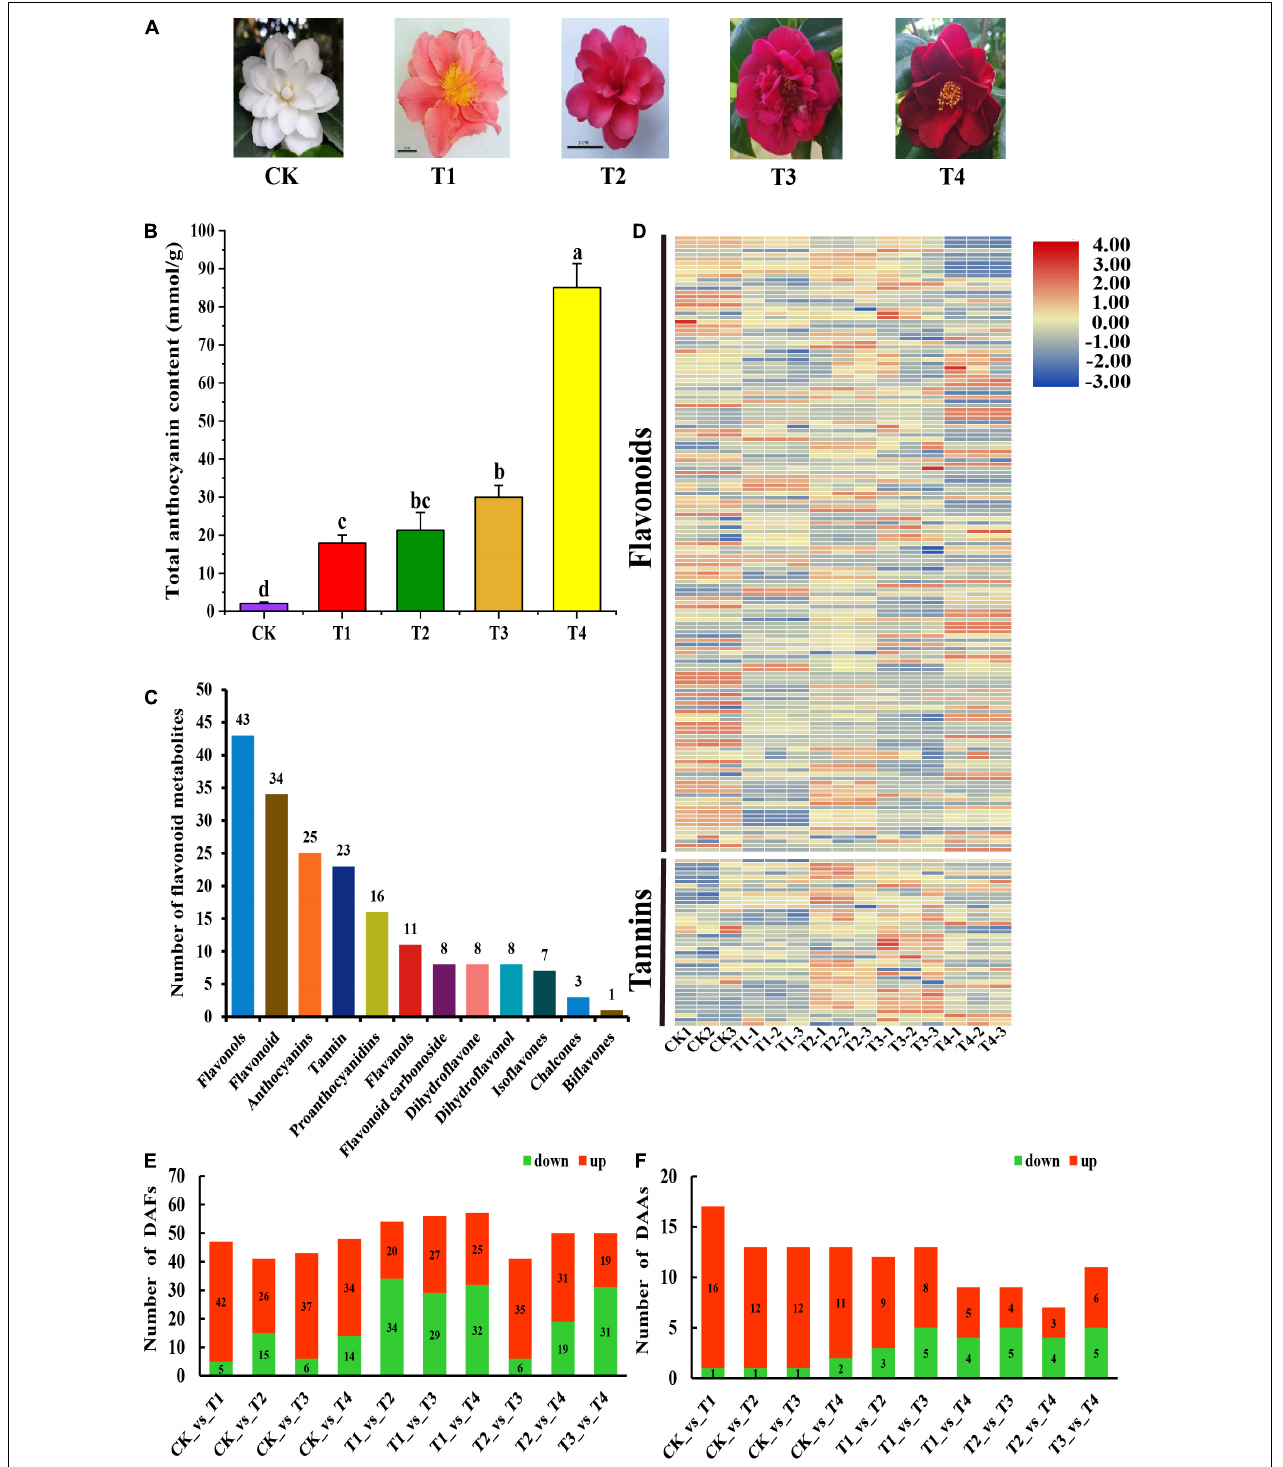
FIGURE 1 | Phenotypes Comparison of phenotypes, composition and content of anthocyanins among five C. japonica petals. (A) Phenotypes of C. japonica petals. (B) Total anthocyanin content of C. japonica petals. All data were shown as mean ± SE ( n = 3). Means with different letters at each treatment represented a significant difference at p ≤ 0.05. (C) Classification and statistical analysis of all metabolites detected. (D) The heatmap analysis of all metabolites relative content by TBtools. (E) Number of DAFs among all comparison units. (F) Number of DAAs among all comparison units.